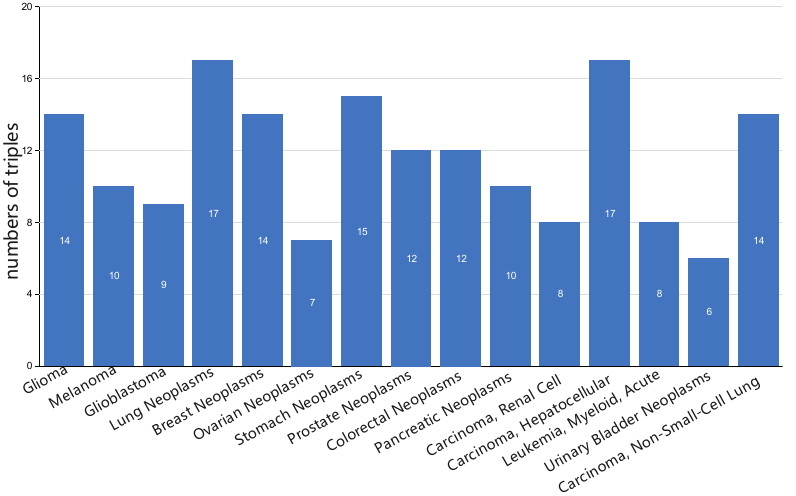
Figure 6. Case study on 15 diseases unique in HMDD v3.2. The training model is based on the miRNA-disease-type triples recorded in HMDD v2.0. Numbers of predicted miRNA-disease associa- tions, which are confirmed by HMDD v3.2, are highlighted in the middle of the bars. Table 4. miRNA-disease associations predicted by our model trained on HMDD v3.2 with their association types and their supporting literature from